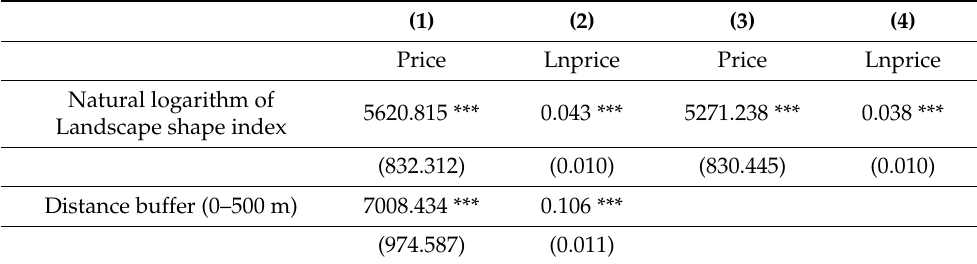
Table 5. Results of robustness